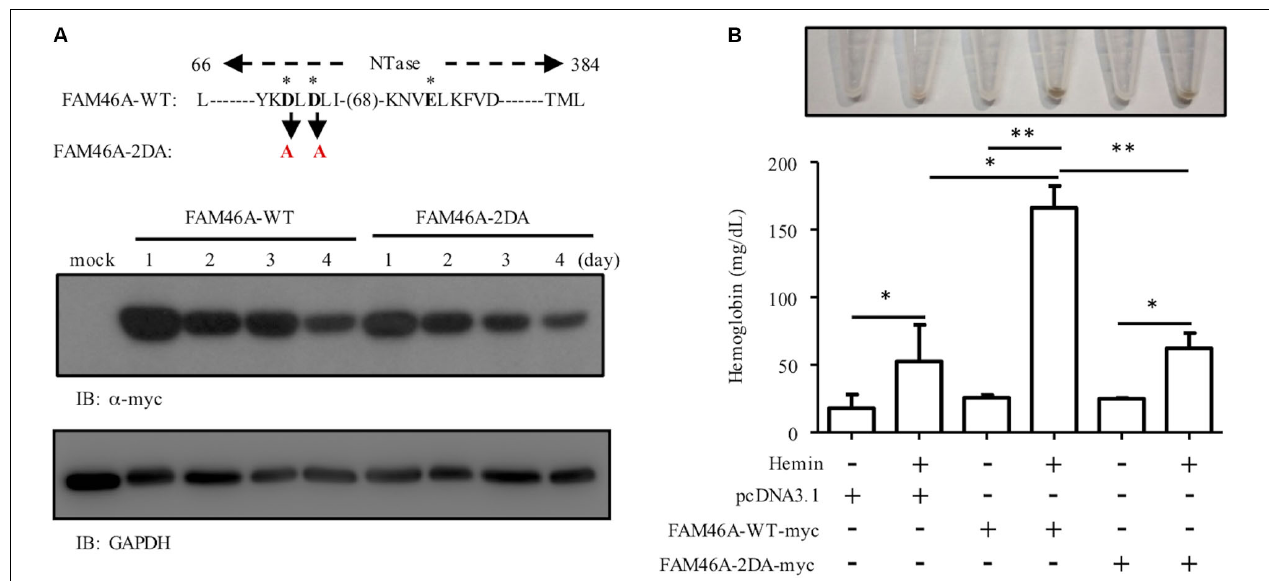
FIGURE 7 | The poly(A) polymerase activity is necessary for the role of FAM46A in promoting erythroid differentiation. (A) WB analysis of the expression of FAM46A-WT and FAM46A-2DA in transfected K562 cells at different time points as indicated. The FAM46A protein sequence of interest is listed for the WT molecule, while the specific mutated residues are highlighted in red (and denoted in black arrow). The three asterisks represent the conserved NTase active site residues. (B) The effect of the FAM46A-2DA mutant variant on the modulation of K562 erythroid differentiation. Hemoglobin production is analyzed in K562 cells transfected with indicated FAM46A expression constructs and treated with or without hemin for 3 days ( n = 3, mean ± SD; ∗ p < 0.05, ∗∗ p < 0.01, ns,